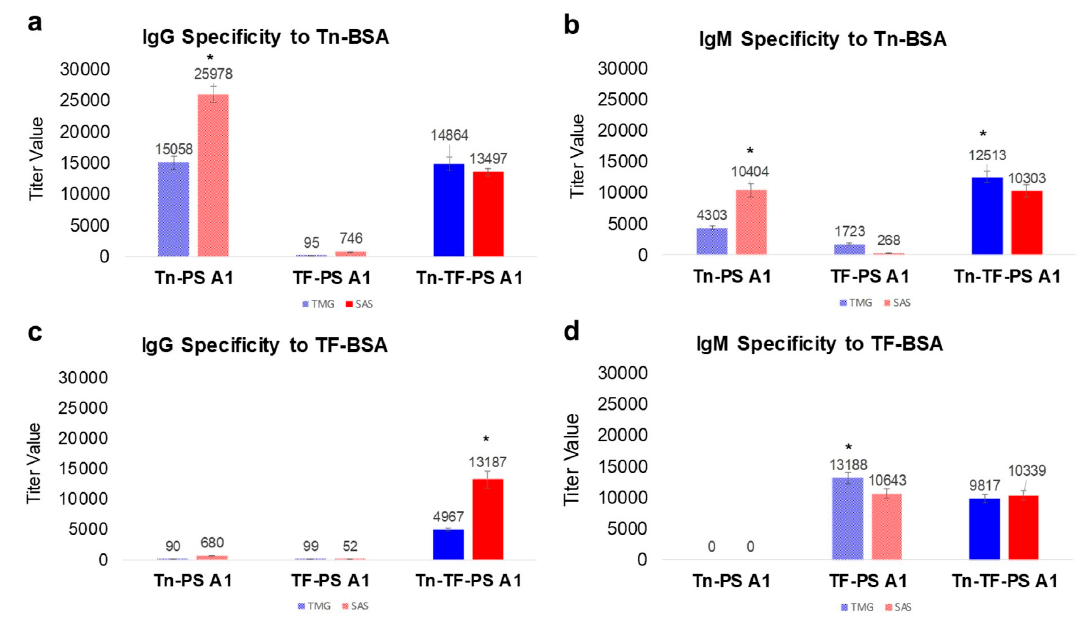
Figure 1. Serum polyclonal antibody specificity to Thomsen-nouveau-bovine serum albumin (Tn-BSA) or Thomsen-Friedenreich (TF)-BSA conjugates. Groups of mice (n = 5) were immunized with tumor associated carbohydrate antigen (TACA)-PS A1 conjugates ( 4a , 4b , or 4c ) in conjunction with TiterMax ® Gold (TMG) (blue bars) or Sigma Adjuvant System ® (SAS) (red bars). ELISA experiments were performed in triplicate. ( a ) IgG specificity towards Tn-BSA. ( b ) IgM specificity towards Tn-BSA. ( c ) IgG specificity towards TF-BSA. ( d ) IgM specificity towards TF-BSA. Both PS A1 and PBS served as controls in our murine immunization studies and there was no cross-reactivity observed to either Tn-BSA or TF-BSA. Error bars are derived from variations in response and are shown as mean ± standard error of mean. Significance is noted between adjuvant groups TMG and SAS. Where * p < 0.05 was obtained by two tailed Student’s t -test.